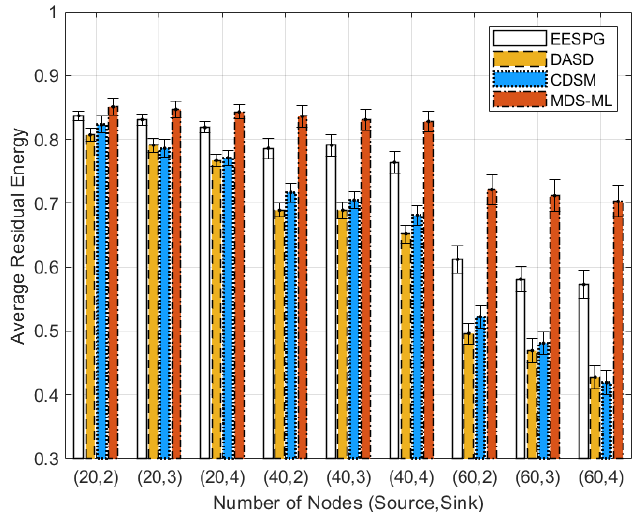
Figure 8. Average residual energy with different number of nodes.